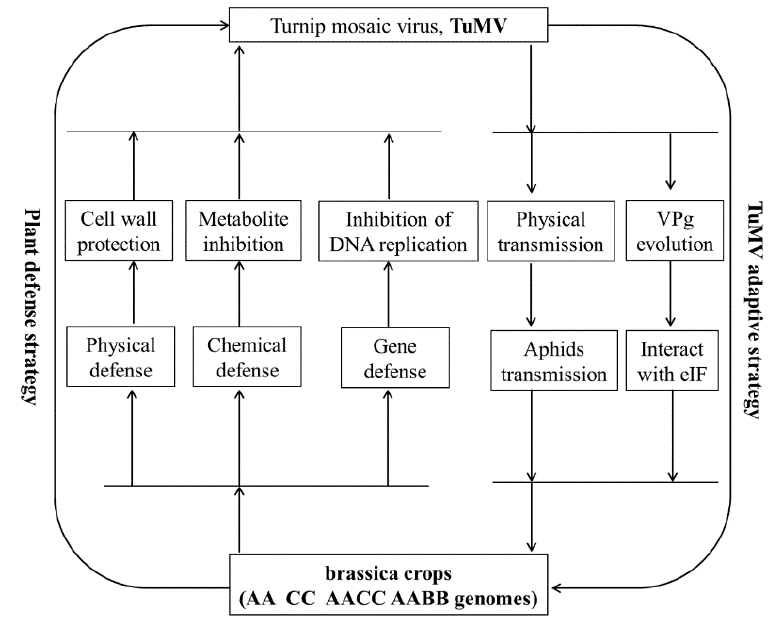
Figure 2. The interaction ways between brassica crops and TuMV. Supplementary Materials: The following are available online at www.mdpi.com/xxx/s1, Figure S1: Biosynthetic pathway of green leaf volatiles (GLVs).